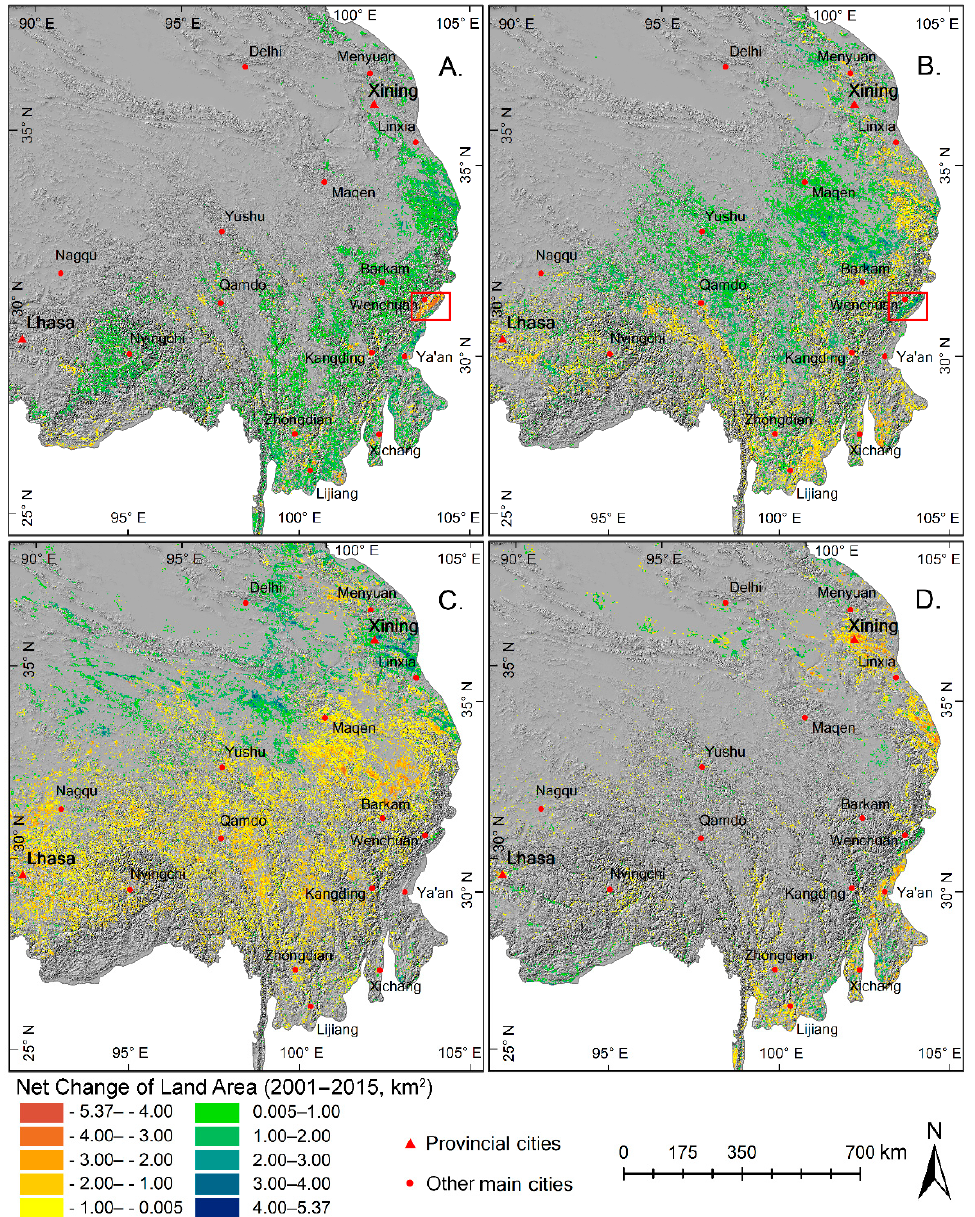
Figure 3. Net changes of ( A ) forest, ( B ) closed shrubland, ( C ) meadow, and ( D ) agriculture from 2001–2015. The red box in ( A , B ) indicates the forest habitats destroyed by the earthquake in 2008. Land changes are significant with a p -value < 0.1.